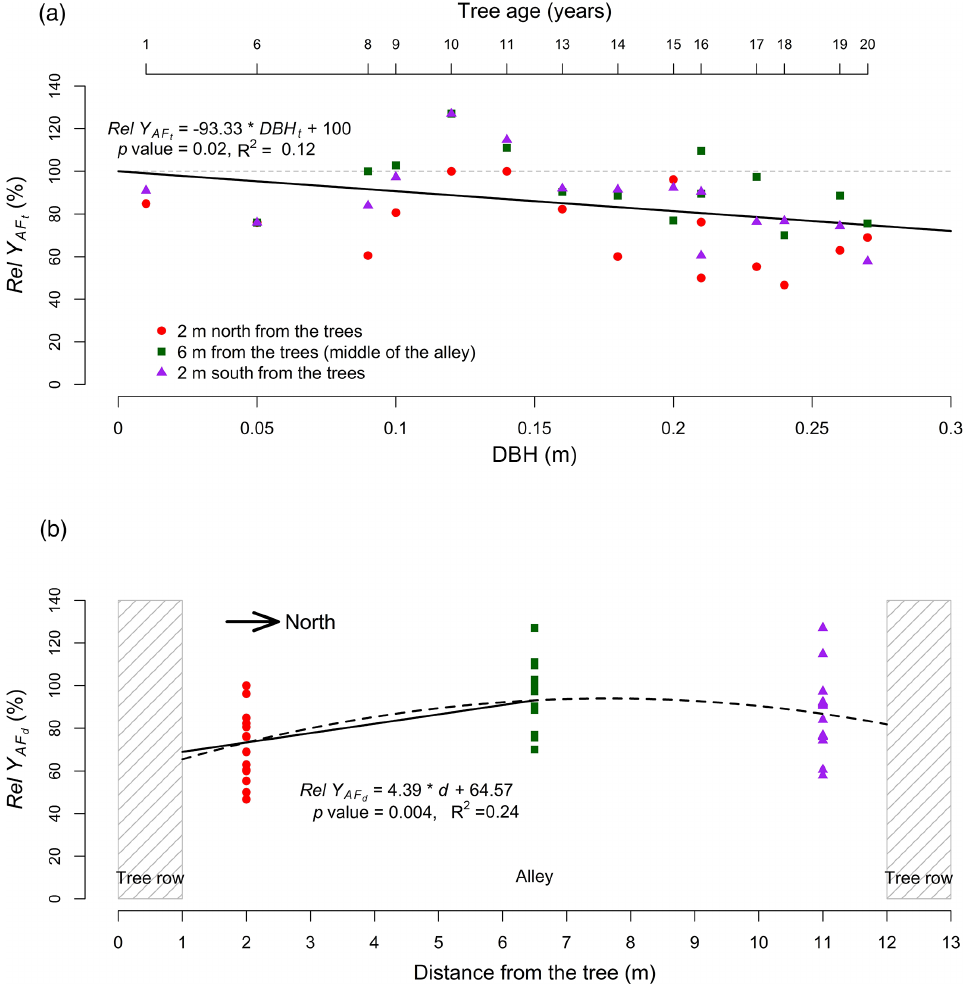
Figure 3. (a) Relative yield ( Rel Y AF ) in the agroforestry plot compared to the control plot as a function of tree growth, represented by the t diameter at breast height (DBH) at year t . (b) Relative yield ( Y AF ) as a function of the distance from the t,d